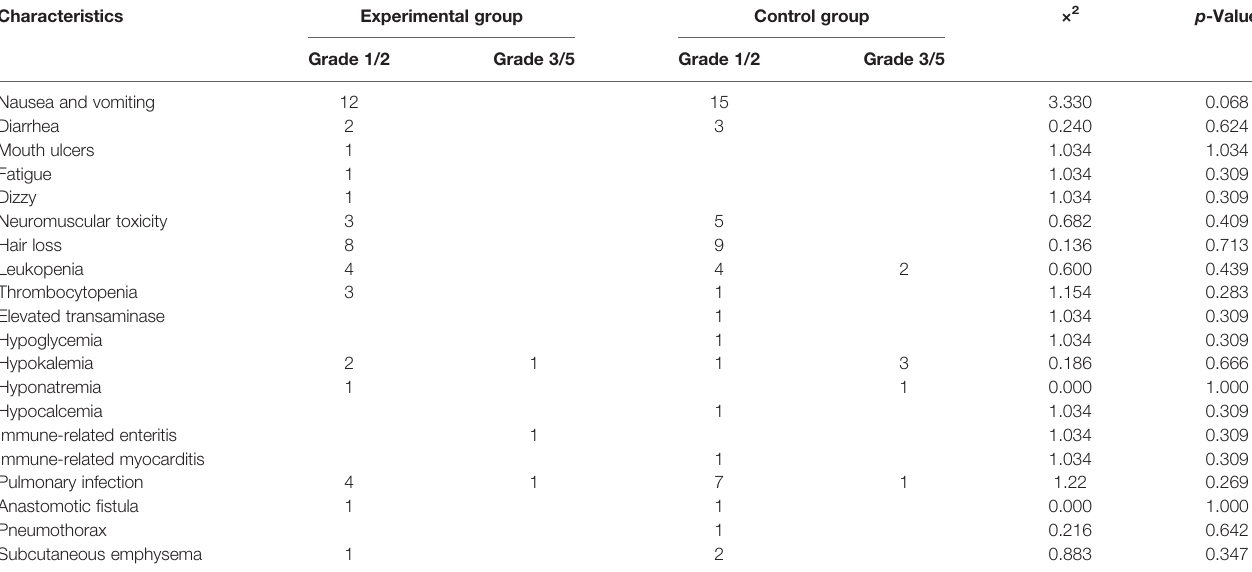
TABLE 2 | Treatment-related adverse events and postoperative complications.